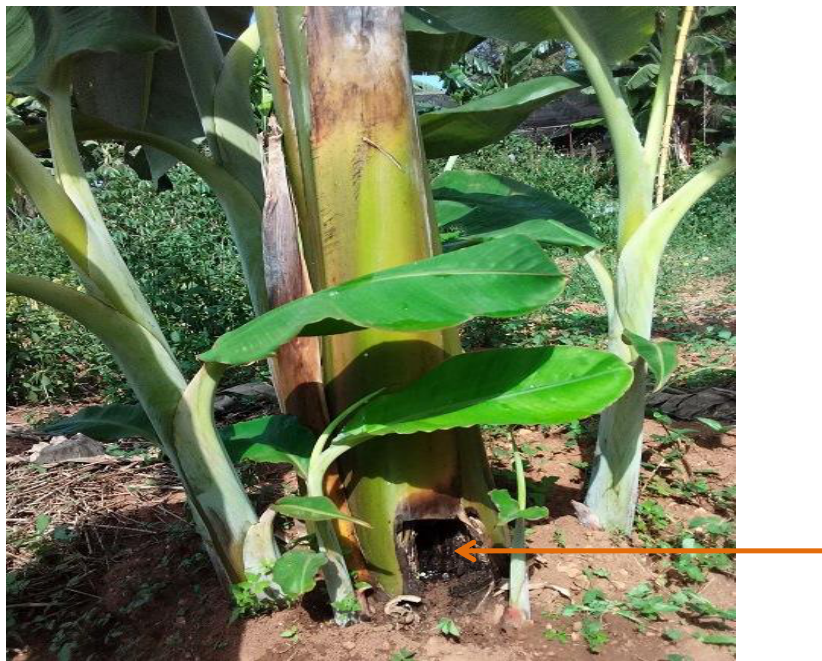
Figure 3: A decapitated banana plant with many suckers growing around it.